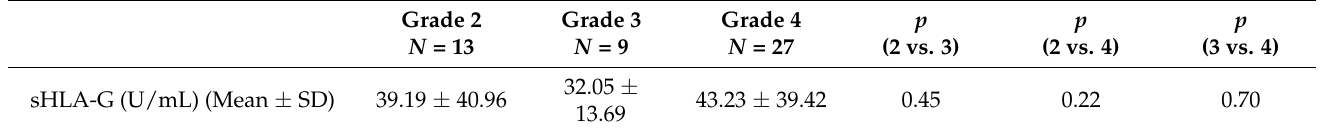
Table 4. Comparison of plasma levels of sHLA-G in different stages of glioma in primary diagnosis ( n =